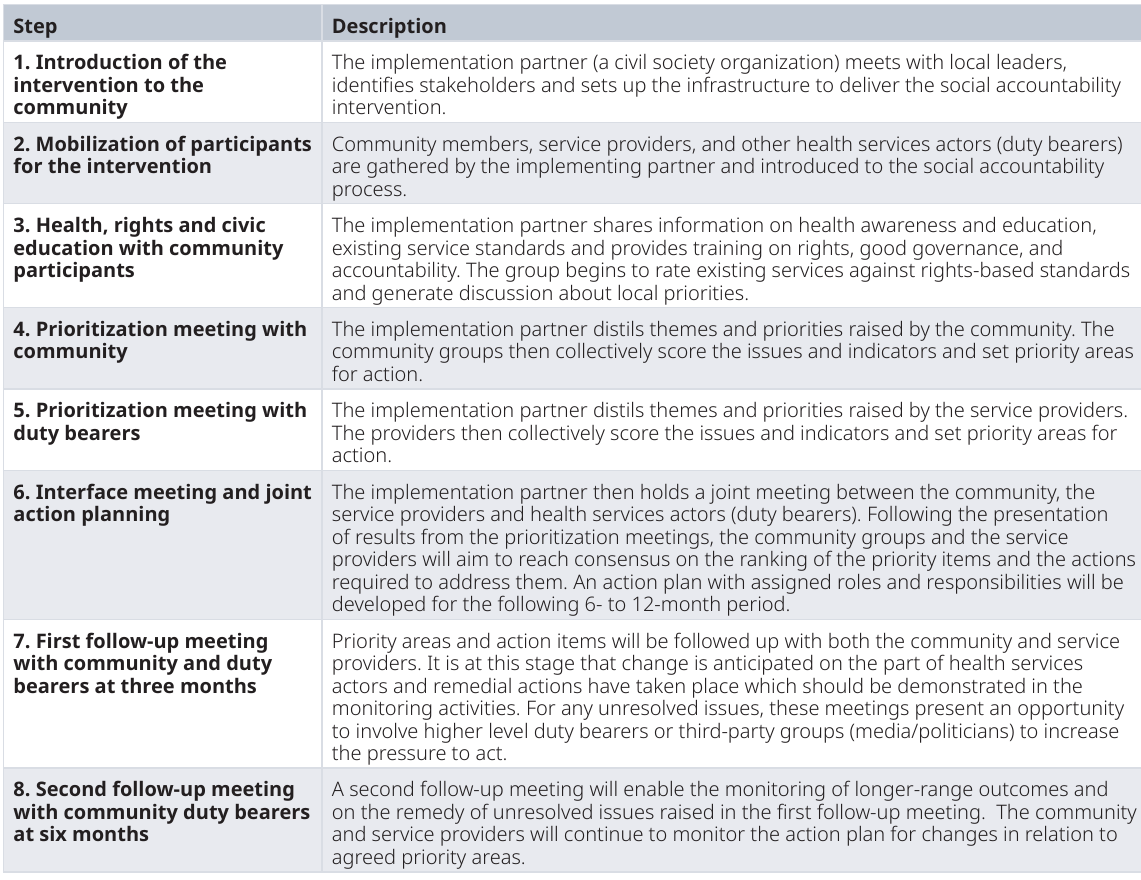
Table 2. Eight standard steps of Community and Health Provider driven Social Accountability Intervention